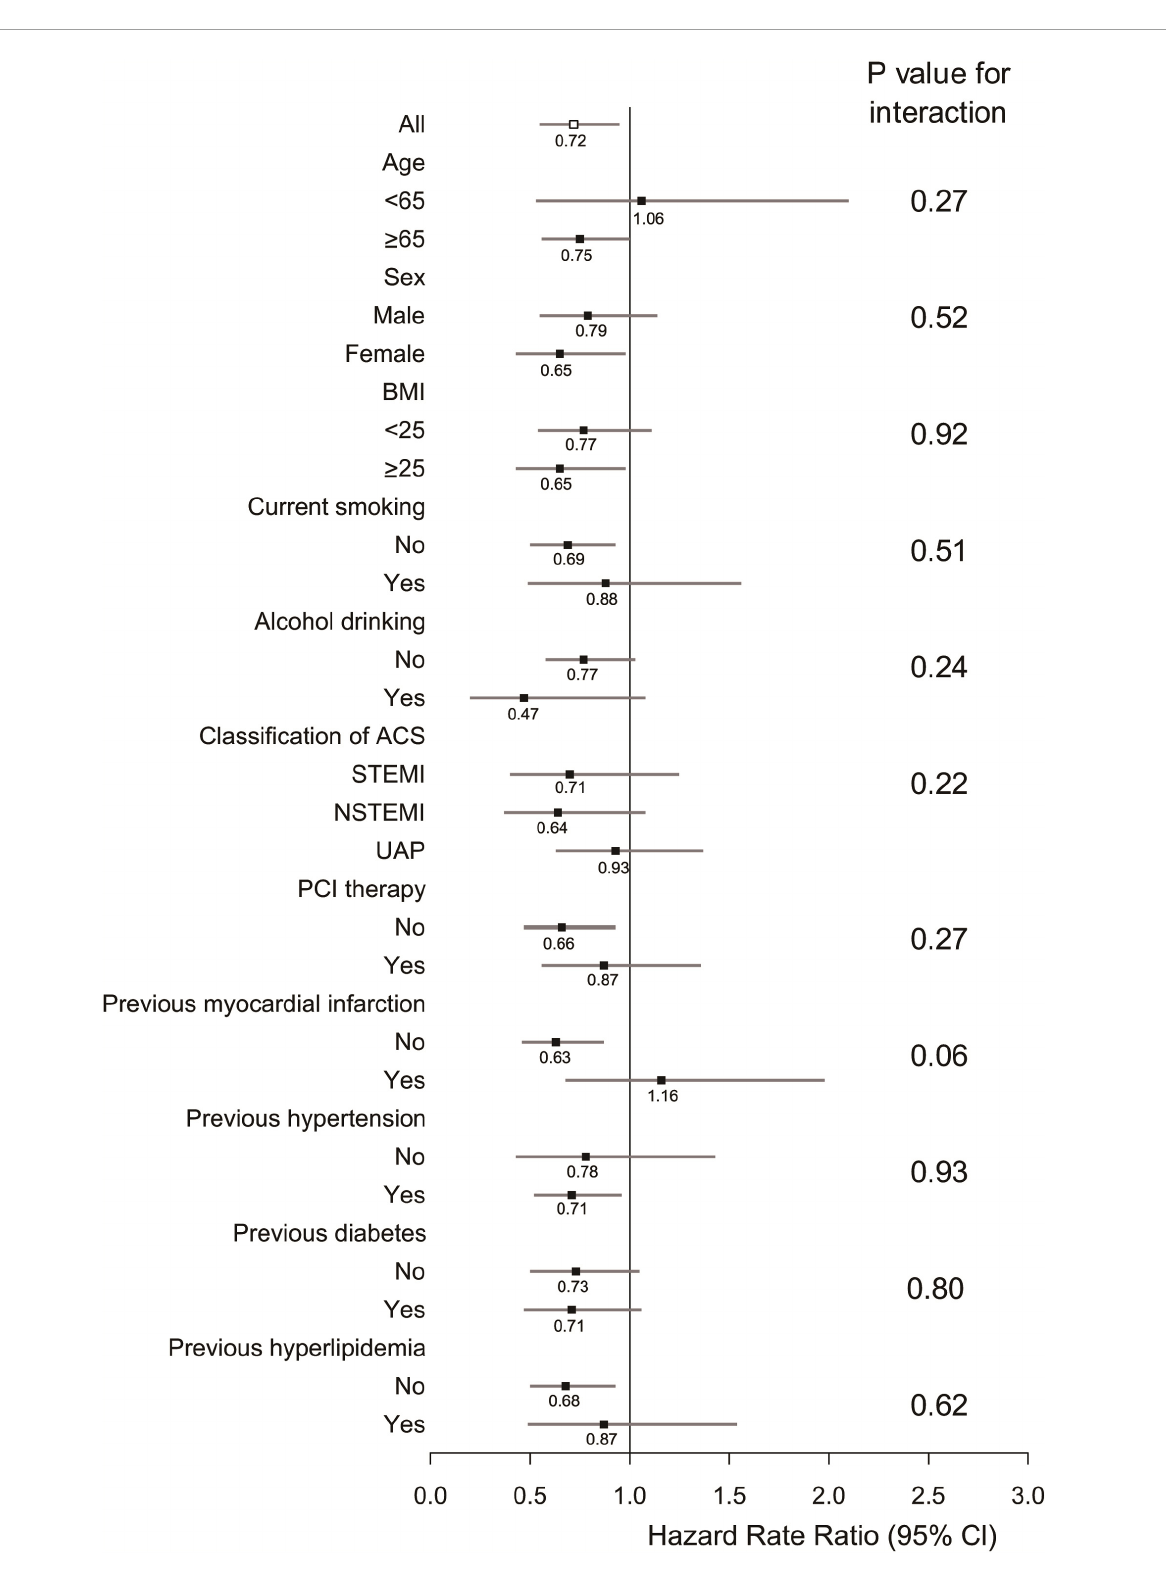
FIGURE2 Subgroup analyses of association between gallstone disease and cardiac mortality according to potential baseline risk factors. Adjustments were made for age, sex, body mass index (BMI), smoking habits, alcohol intake, classification of acute coronary syndrome (ACS), percutaneous coronary intervention (PCI) therapy, previous myocardial infarction, hypertension, diabetes, and